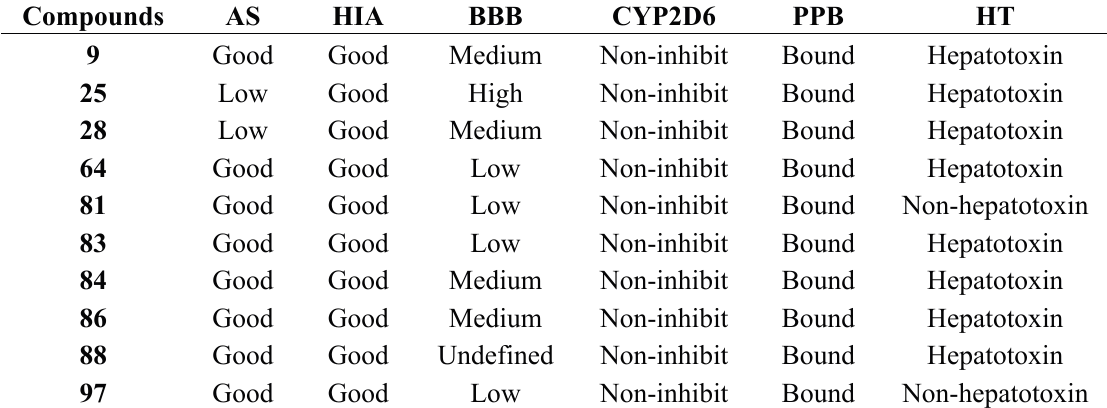
Table 7. Results of absorption, distribution, metabolism, excretion, and toxicity (ADMET) predictions on six important